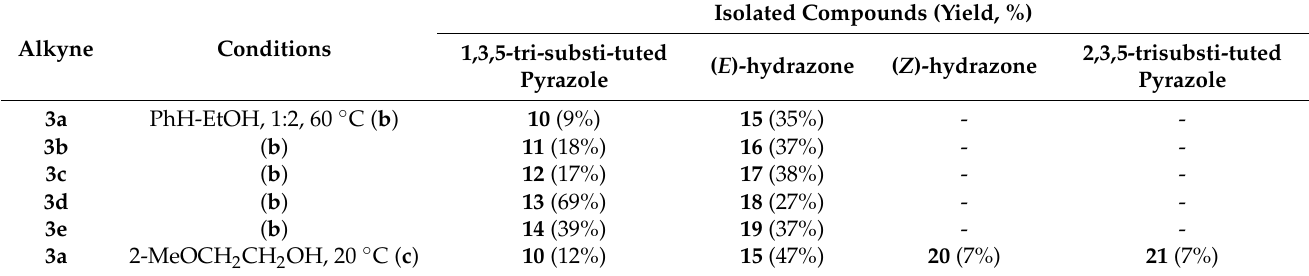
Table 1. The effect of the solvent on the yield of products in the stage of ynedione–phenylhydrazine interaction.